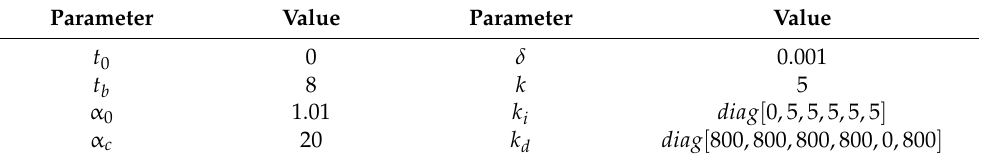
Table 2. Controller parameter set.